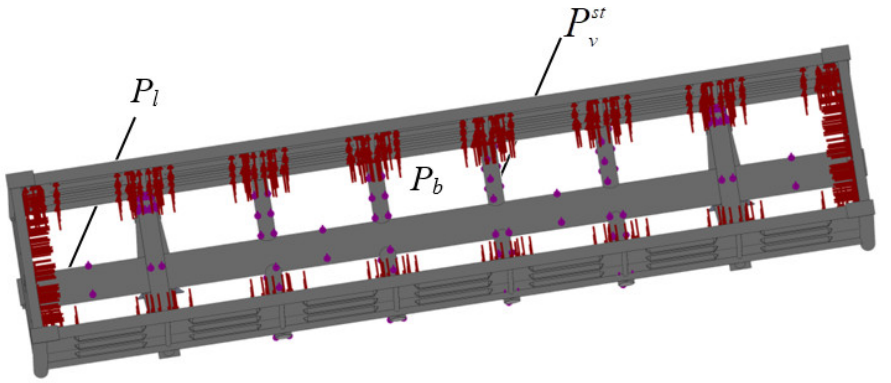
P —the longitudinal force, st l